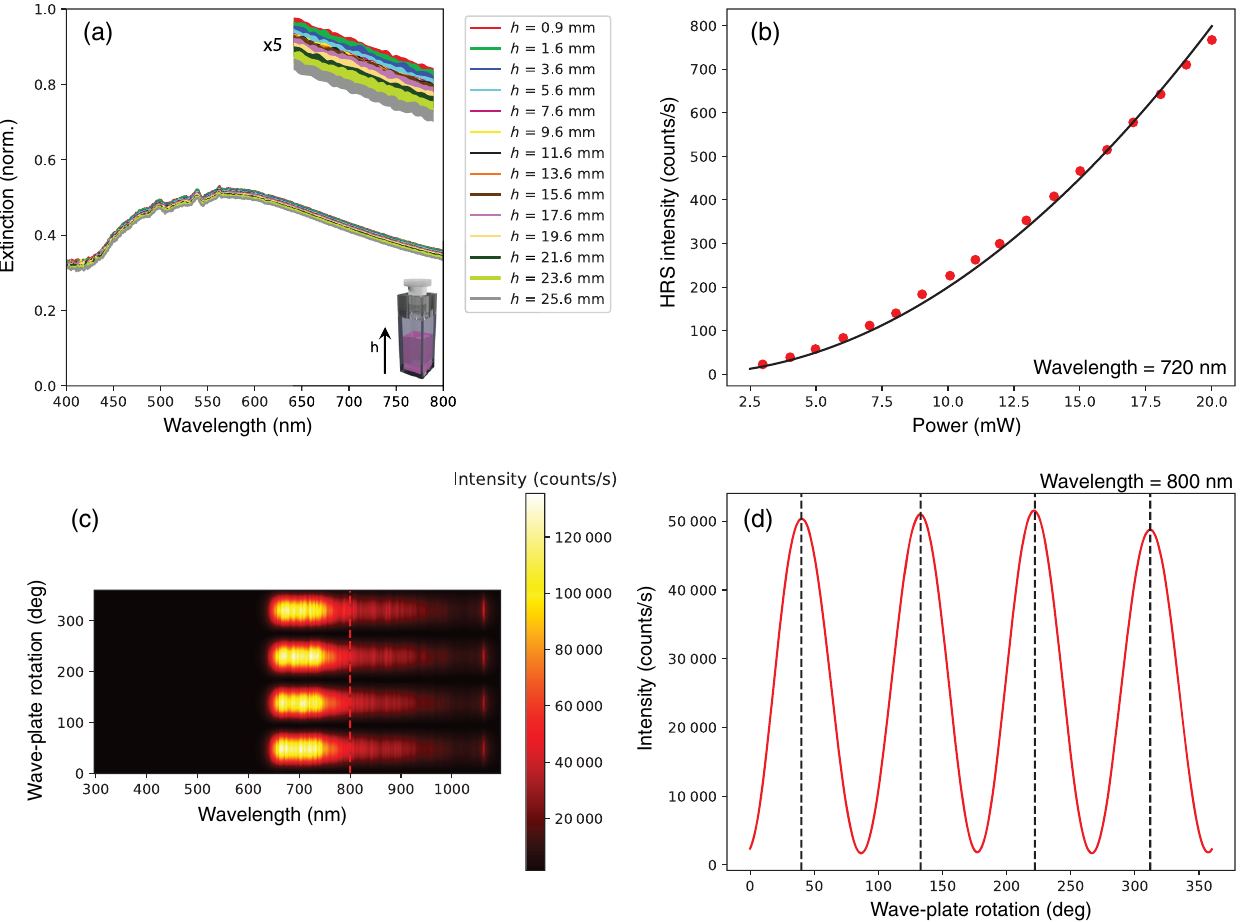
FIG. 5. In (a), optical extinction spectra for a suspension of nanohelices. The spectra were taken in 2 mm, from the liquid surface towards the top of the glass cuvette. A small gradient of concentration can be seen, which is negligible in the focal waist of the HRS experiments (approximately 20 μ m). In (b), the HRS signal is quadratic with the incident power. The red dots correspond to experimental data, and the black line is a corresponding fit. In (c), the light intensity spectra in transmission through the achromatic quarter-wave plate placed between crossed polarizers and plotted as a function of wave plate rotation angle. In (d), the light intensity at 800 nm, in transmission through the wave plate, as a function of wave-plate rotation